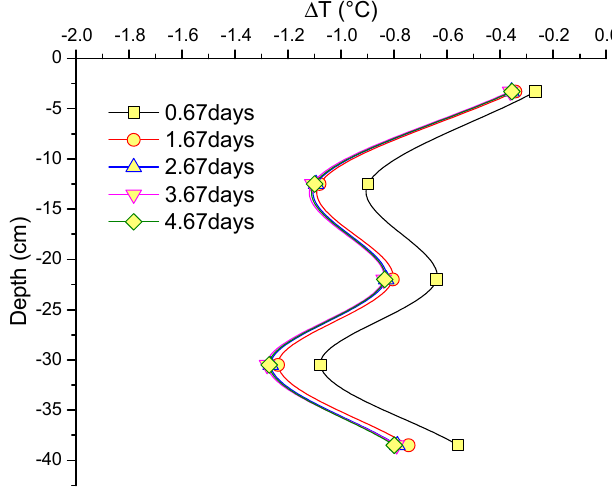
Figure 7. Distribution of the temperature difference along the pile at different times.